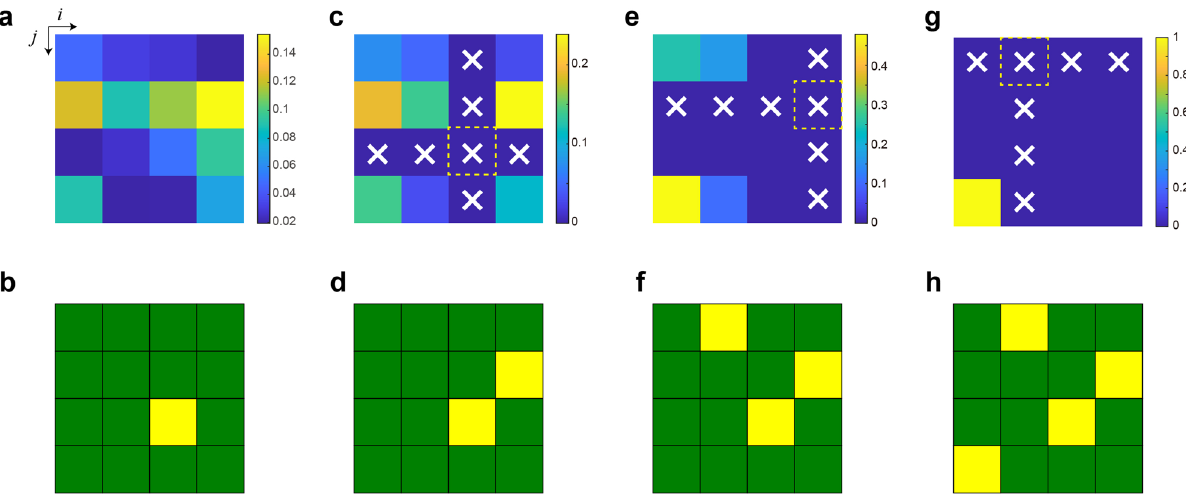
Figure 3. Generation of Schubert polynomials based on optical near-field observation. ( a ) The detection area is divided into N × N elements. Here N = 4. The photon detection probability is spatially irregular. ( b ) When